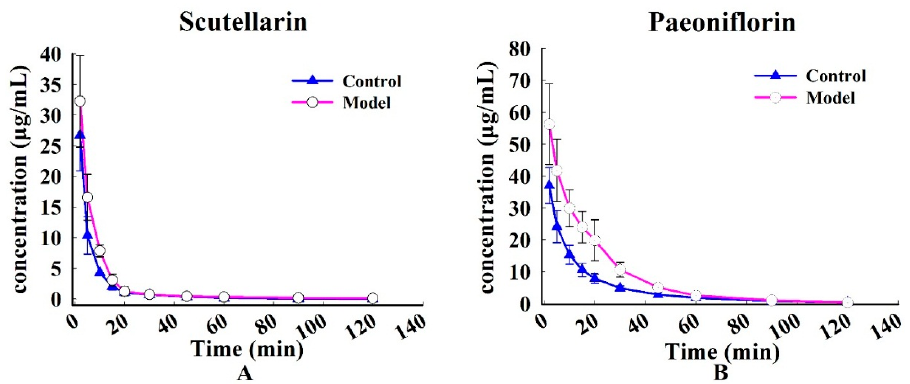
Figure 4. The mean plasma concentration vs. time profile of the two components following the intravenous administration of Xin-Shao formula extracts in sham-operated and MCAO rats. ( A ): scutellarin and ( B ): paeoniflorin. Each value represents mean ± SD ( n = 6). Table 4. Pharmacokinetic parameters of scutellarin and paeoniflorin in rat plasma following intravenous administration of Xin-Shao formula extracts at a dose of 1.25 g/kg (mean ± SD, n = 6). Scutellarin Paeoniflorin Parameters Sham-Operated Group MCAO Group Sham-Operated Group MCAO Group